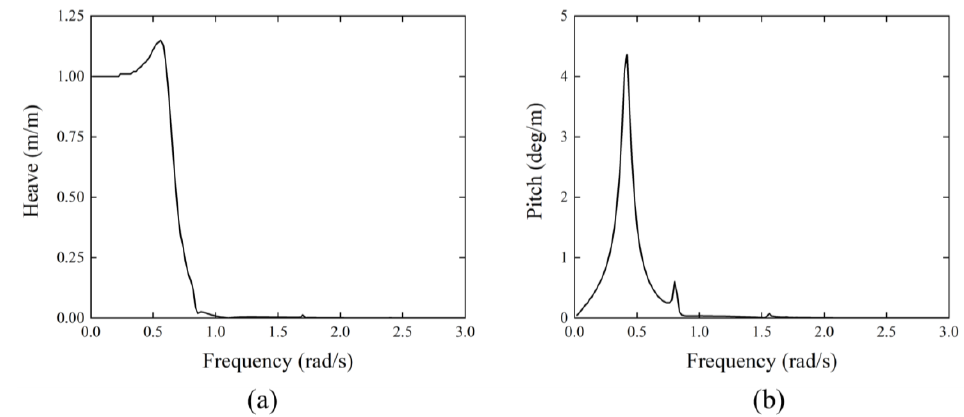
Figure 5. The RAO of ( a ) heave and ( b ) surge in frequency domain. Table 3. Natural periods of different platforms for pitch at 0° direction.